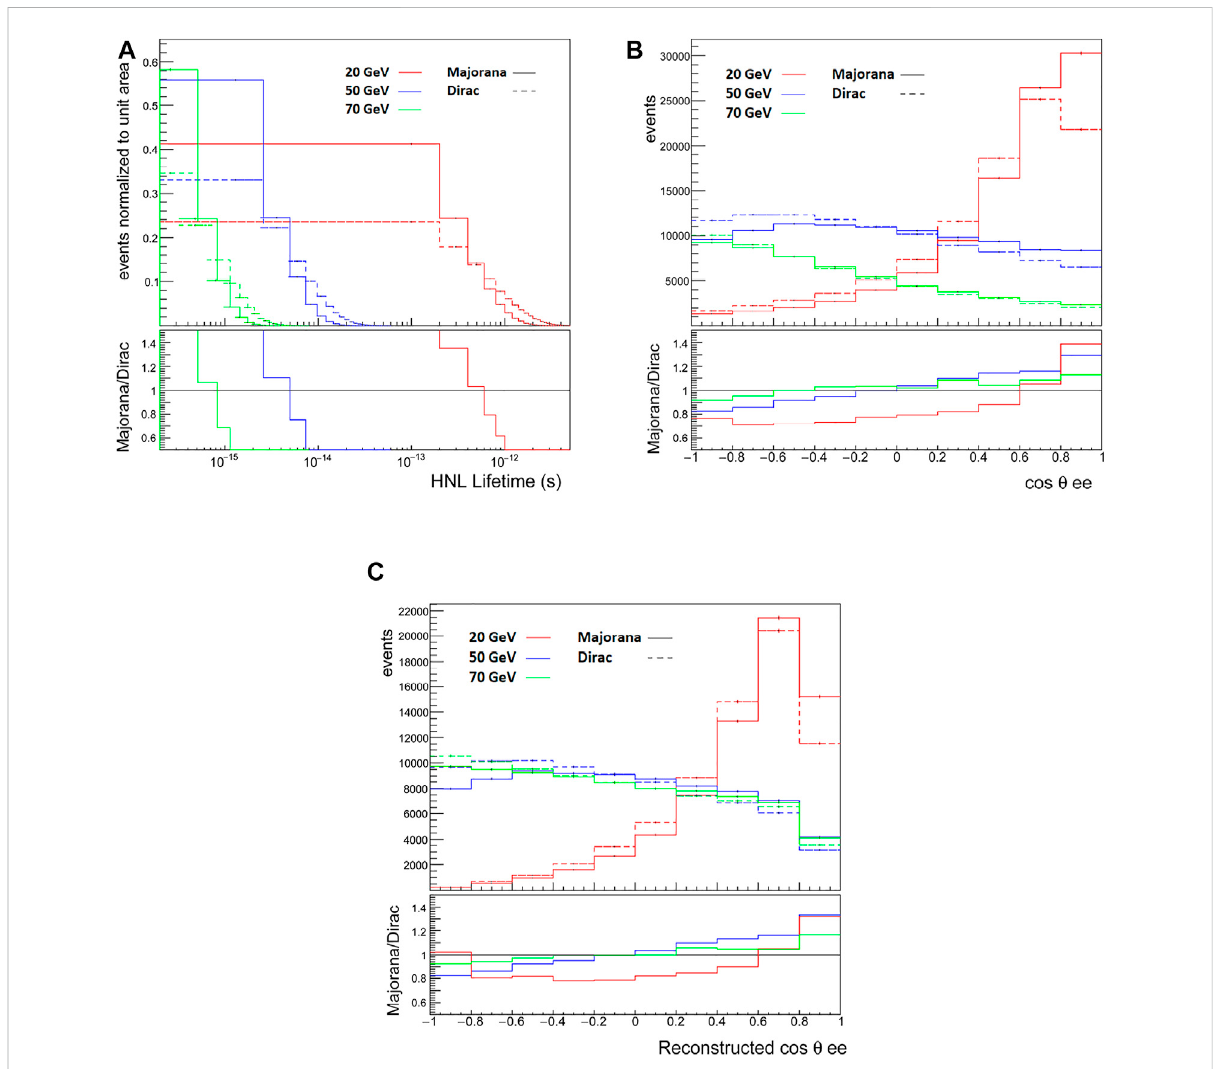
FIGURE 17 (A) The normalized distribution of lifetimes of Dirac (dashed) and Majorana (solid) HNLs in the processes de fi ned in Eq. 22, for representative masses and assuming | V eN | = 10 – 3 . (B) The generator-level angular separation cos θ ee for Dirac and Majorana HNLs under the same scenario. (C) Same as (B) but at the reconstruction